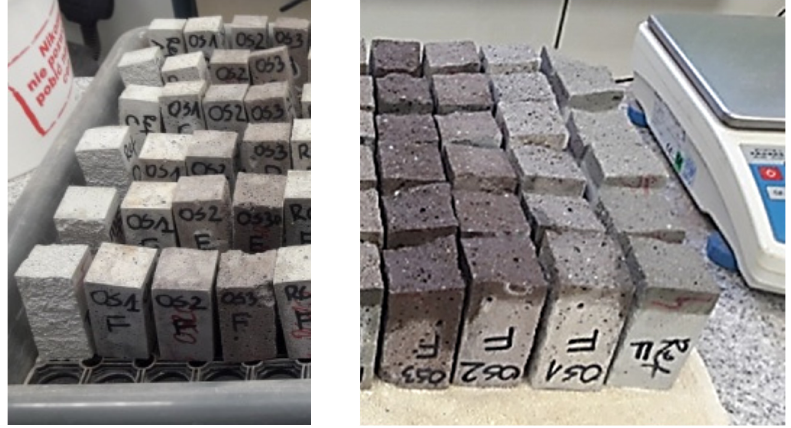
Figure 15. Specimen during the determination of water absorption coefficient due to capillary ac- tion. 00.10.20.30.40.50.60.7 Figure 16. Water absorption coefficient due to capillary action of hardened mortar. Such a high value of the water absorption coefficient is a result of the porous structure of the waste aggregate with high prevalence of fine pores (Figure 5a). The higher the amount of the waste aggregate the higher the values of this coefficient. However, dynamic increase in the value is visible for mortars with at least 30% of waste aggregate. Results of this test show limited application of those mortars in areas exposed to water. Capillary action is caused by capillary forces. The magnitude of these forces is related to the rate of capillary action and this depends on the size of the pores and their structure. The increase in capillary action correlated with the increase of number of pores in the structure, and its dynamics depends on the pore size [25,26]. 3.8. Water Absorption Water absorption was determined through soaking (Figure 17).